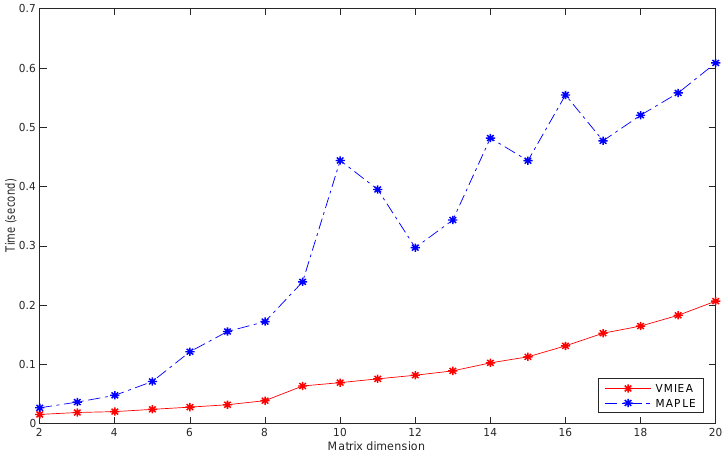
Figure 3. Running time for computing the inverse of numerical Vandermonde matrix V n ,0.25 ( 1,2, . . . , n ) via VMIEA algorithm (in red color) and Maple inversion function for matrices (in blue